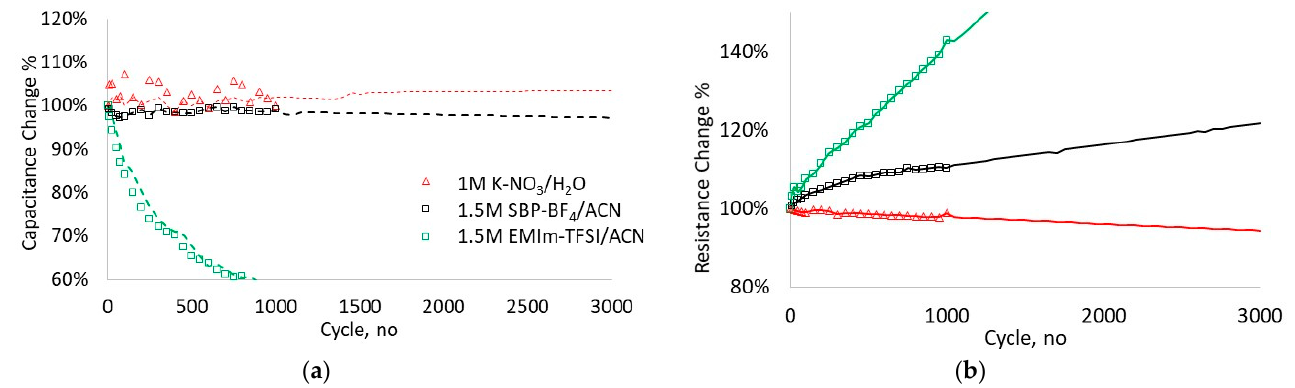
Figure 8. Cycle-life performance of fibrous CDC-based electrodes of 1000 cycles (shapes) with extrapolation of 3000 cycles (lines): ( a ) capacitance retention by CV at 20 mV s − 1 and ( b ) series resistance change during cycling by EIS.